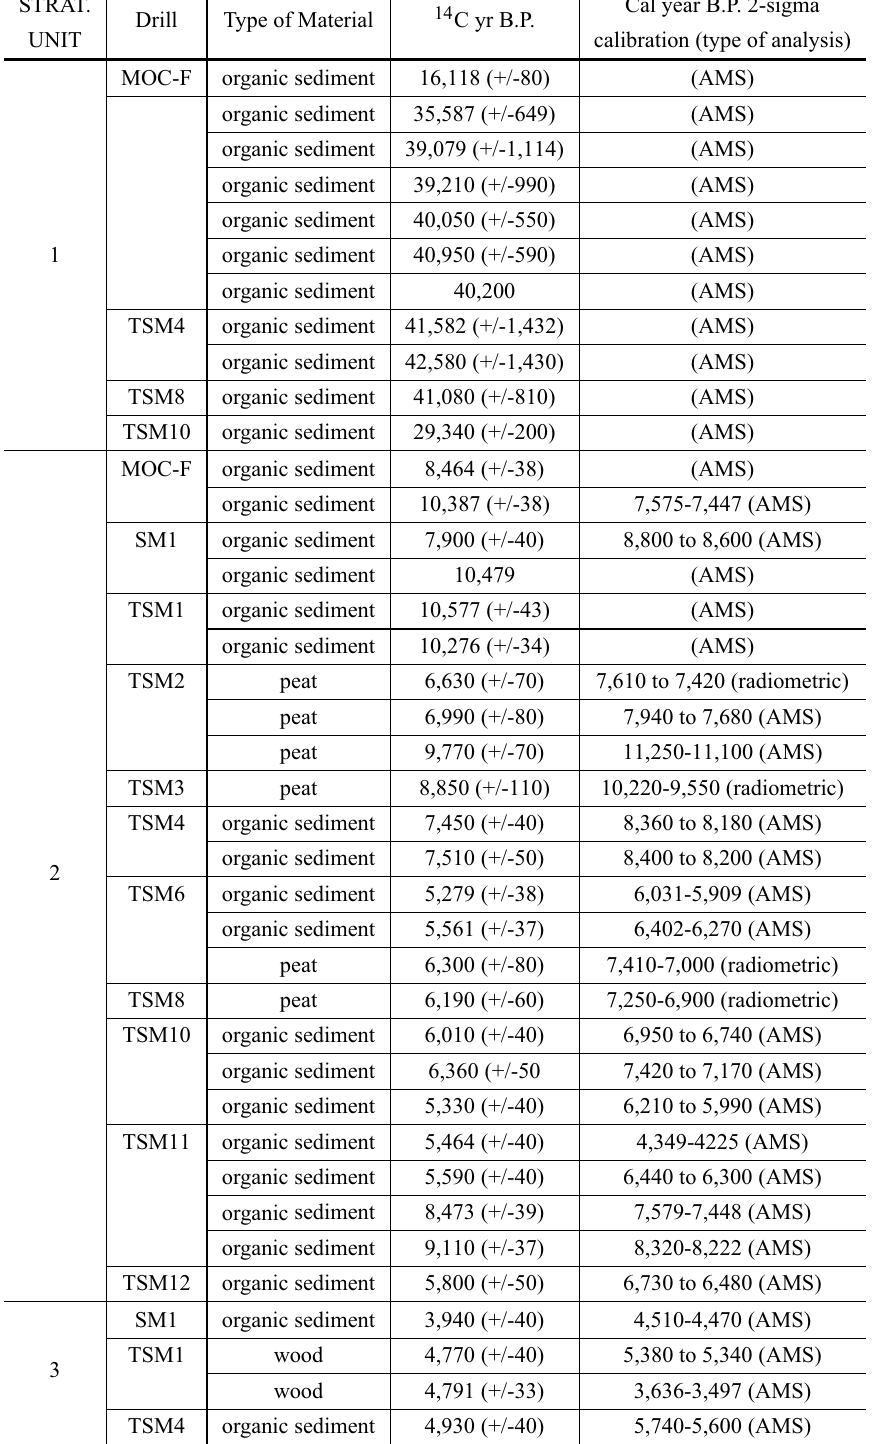
Radiocarbon ages for samples collected from the three stratigraphic units of the study area.